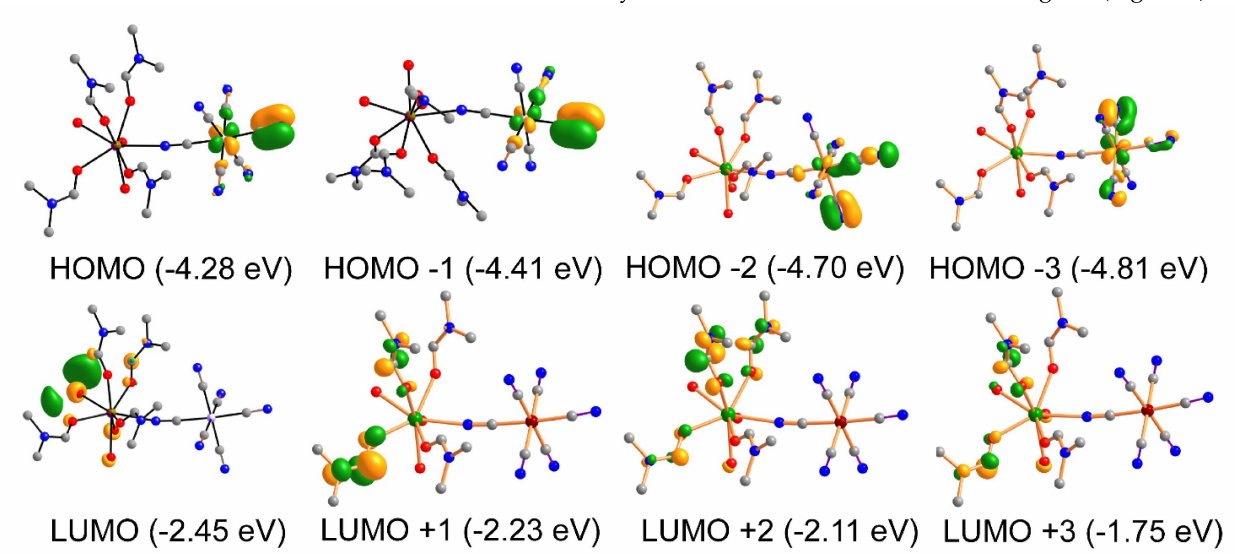
Figure 3. FMO involved in the electronic transitions that were observed in time-dependent DFT (TDDFT)-calculated UV–Vis spectrum of 1